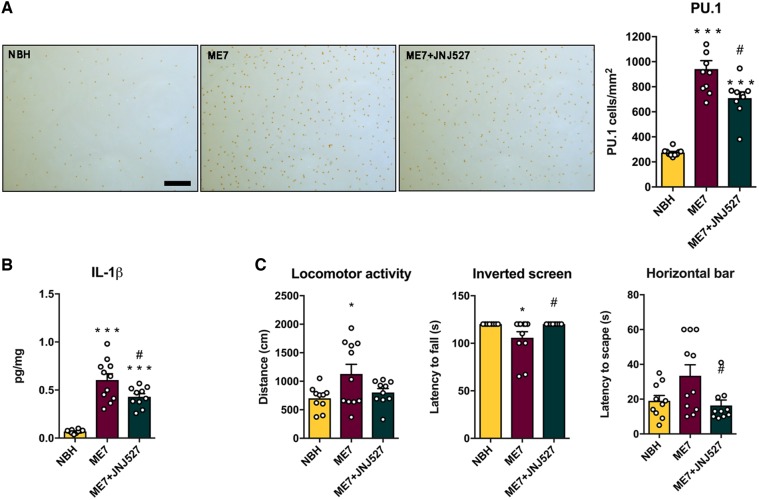

Inhibition of CSF1R by JNJ-527 reduces microglial expansion and restores behavioural alterations in ME7 mice. (A) Long-term JNJ-527 resulted in a significant reduction in the number of microglia (PU.1) in CA1 of the hippocampus. Representative images of PU.1 staining in CA1 hippocampus of NBH, ME7 and ME7+JNJ-527 mice. Scale bar = 50 μm. (B) JNJ-527 treatment diminished the expression of IL1-β and (C) attenuated the hyperactive behaviour (locomotor activity) and completely prevented the onset of motor deficits (inverted screen and horizontal bar). For all quantifications, NBH n = 10, ME7 n = 8, ME7+JNJ-527 n = 9. Values are mean ± SEM. *P < 0.05 ***P < 0.001 versus NBH; #P < 0.05 versus ME7.